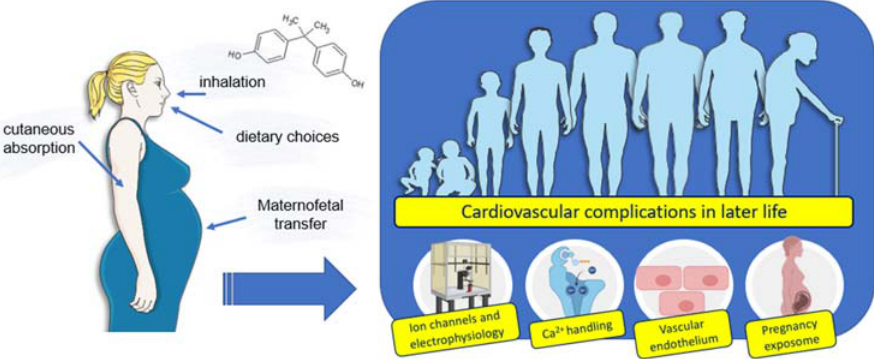
Figure 3. Summary representation of Bisphenol A (BPA) exposure pathways and main mechanisms involved in BPA-induced cardiotoxicity.